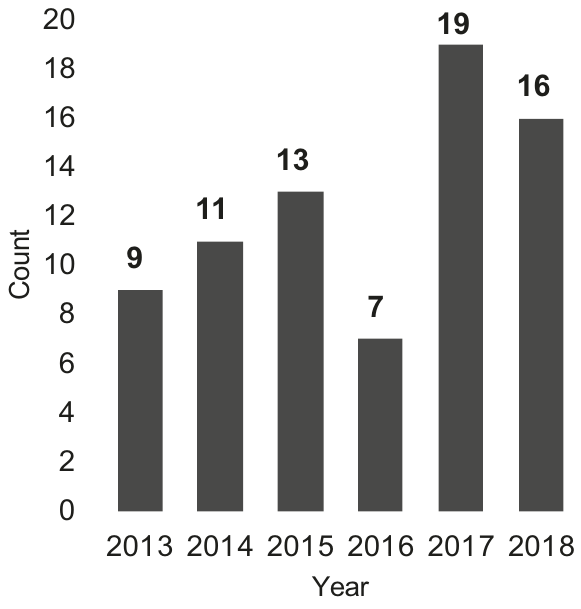
Fig. 1 Publication counts by year. In this graph, we display the publication counts in our corpus from 2013 to 2018.